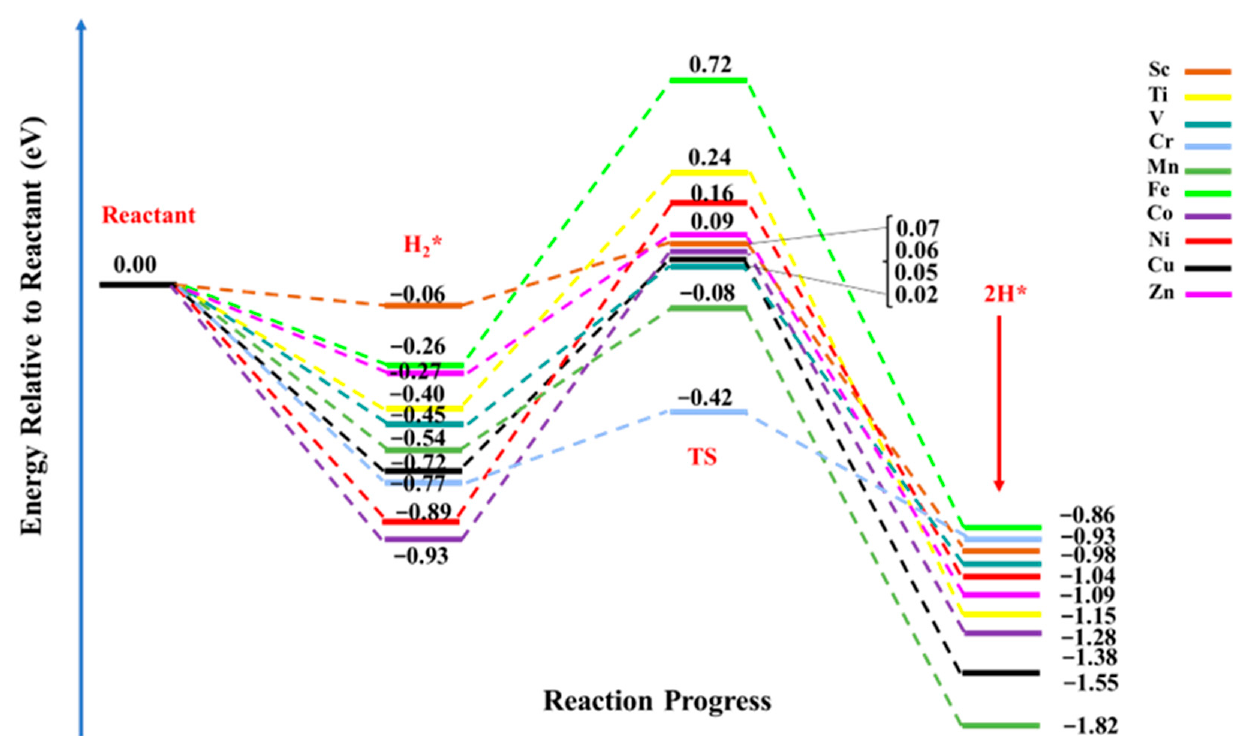
Figure 5. Hydrogen dissociation reaction pathway over TM@NB (TM = Sc-Zn) catalysts; all energy values are expressed in eV, and the energies of intermediate state (H 2 *), transition state (TS), and final state or products (2H*) are relative to the reactants.